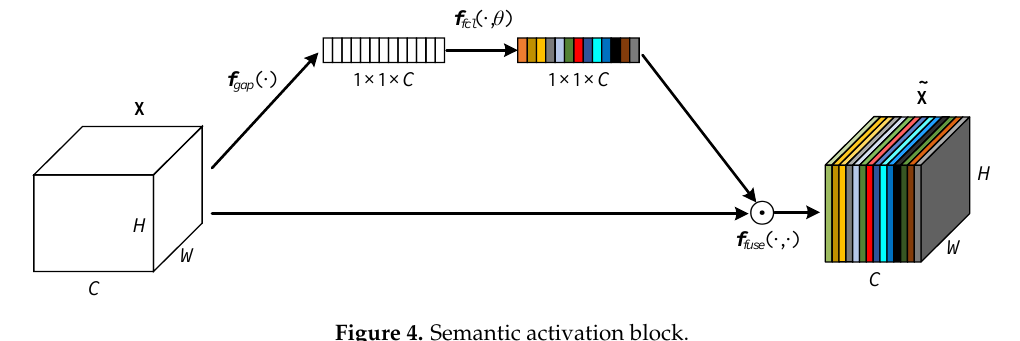
Figure 4 Semantic activation block Figure 4. Semantic activation